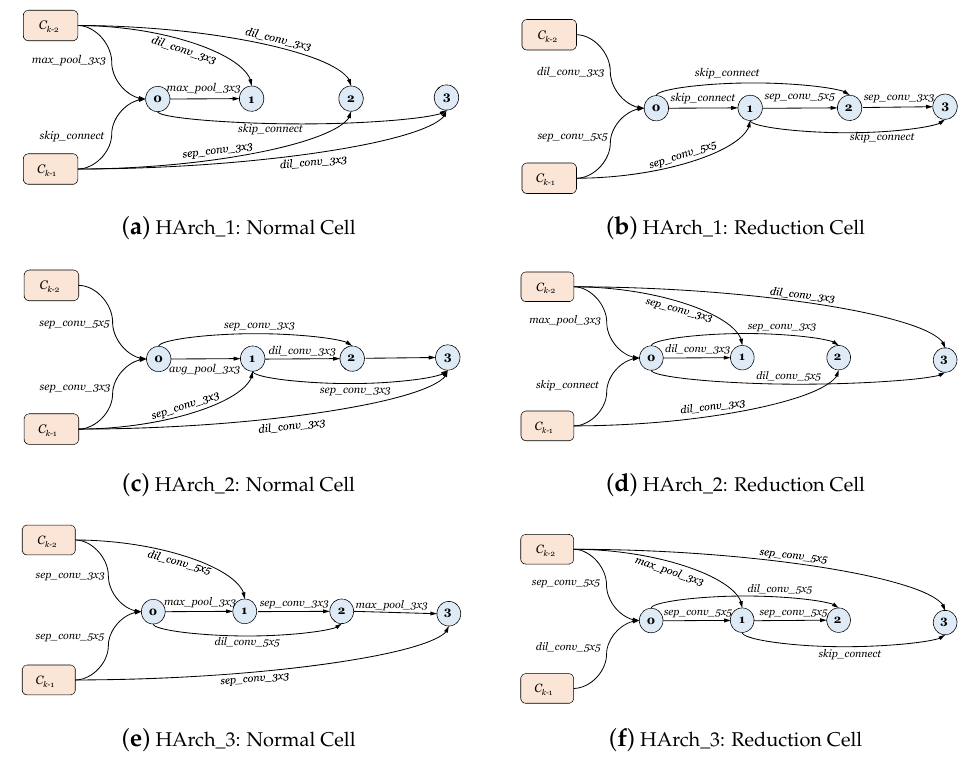
Figure A1. Cell structures of HArch_1, HArch_2 and HArch_3.